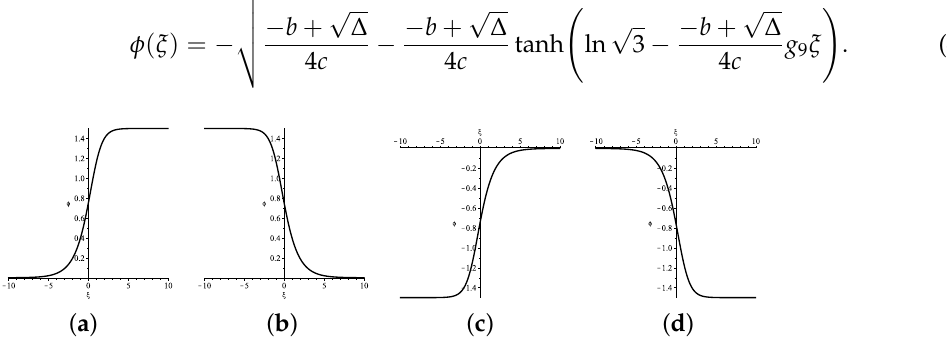
Figure 18. Kink and anti-kink wave forms of system (5). ( a ) Kink wave given by (43). ( b ) Anti-kink wave given by (44). ( c ) Kink wave given by (45). ( d ) Anti-kink wave given by